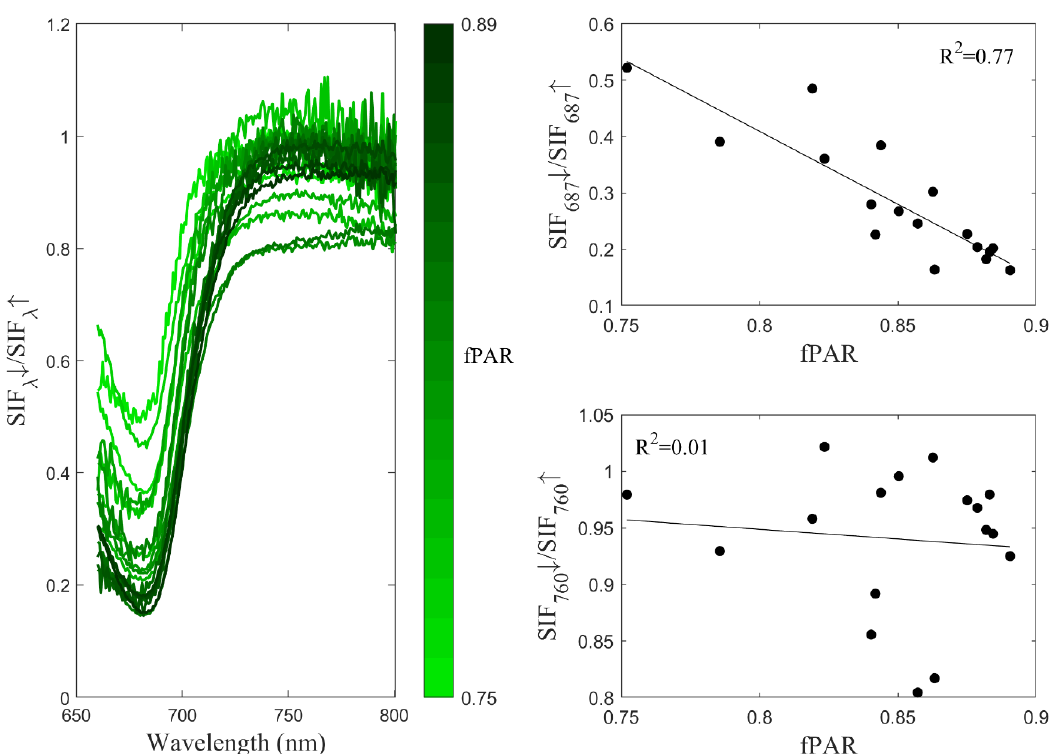
Figure 6. Downward SIF ( 𝑆𝐼𝐹 (cid:3090) ↓ ) and upward SIF ( 𝑆𝐼𝐹 (cid:3090) ↑ ) ratios for the entire SIF spectrum from 660 nm to 800 nm; colored lines represent the fPAR observed in each leaf. Here, fPAR was used to represent chlorophyll a and b content. The right panel shows the linear relationship between the ratio of downward and upward SIF and fPAR at 687 nm and 760 nm, respectively.